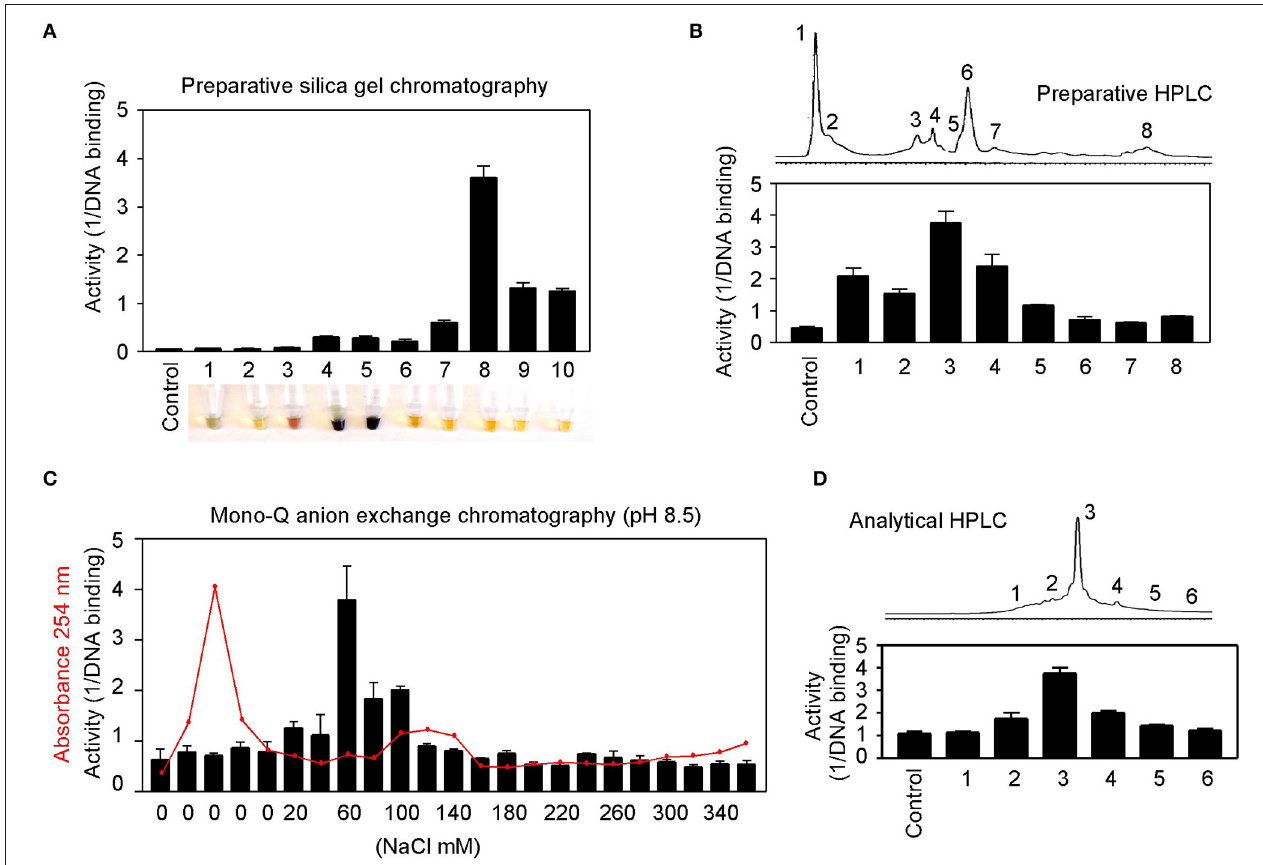
FIGURE 7 | Partial purification of allspice. (A) Ethyl acetate extract of allspice was purified by silica gel chromatography to obtain an active fraction 8. Colors of each fraction are shown below. (B) Fraction 8 was purified by reverse-phase HPLC to obtain an active peak 3. (C) The peak 3 was further purified by mono-Q anion exchange chromatography with active fraction in 60mM NaCl. (D) The 60mM fraction was analyzed by reverse-phase HPLC with each fraction assayed for